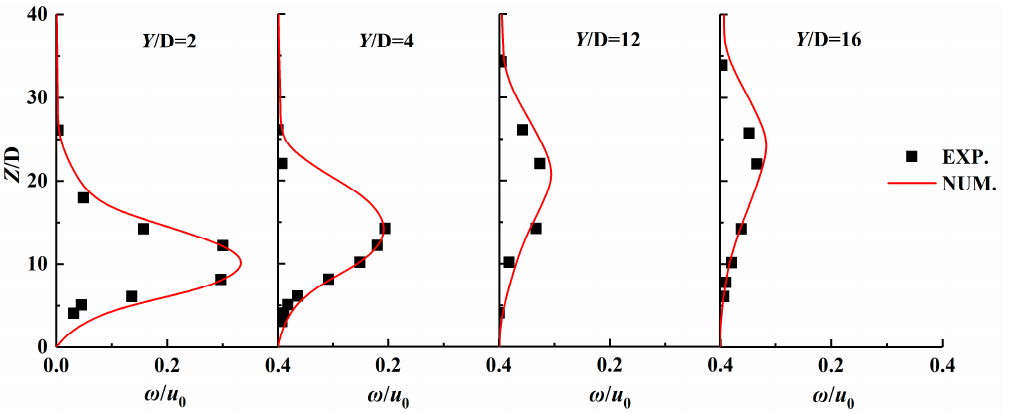
Figure 5. Distribution of the vertical flow velocity along the water depth at different locations.